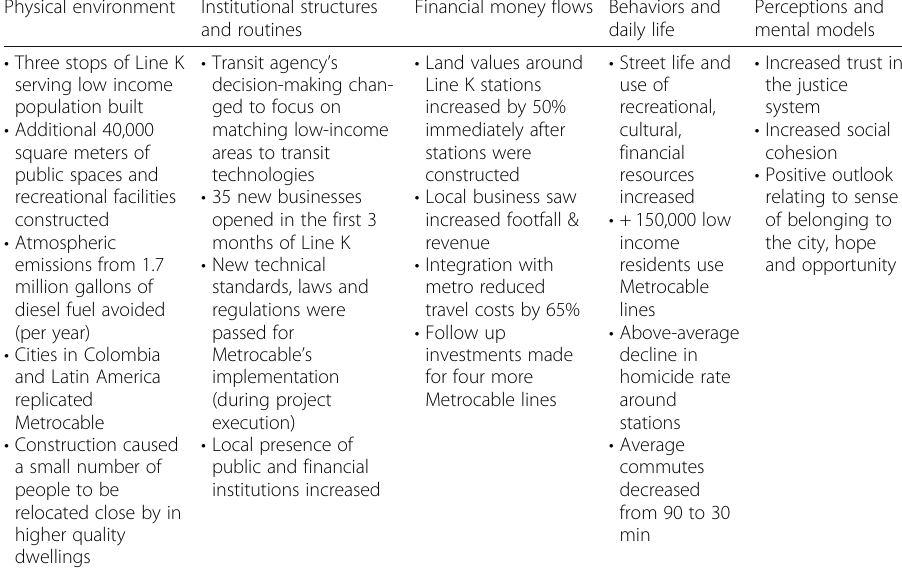
Table 1 Outcomes associated with Metrocable after project implementation (Source: Maassen and Galvin